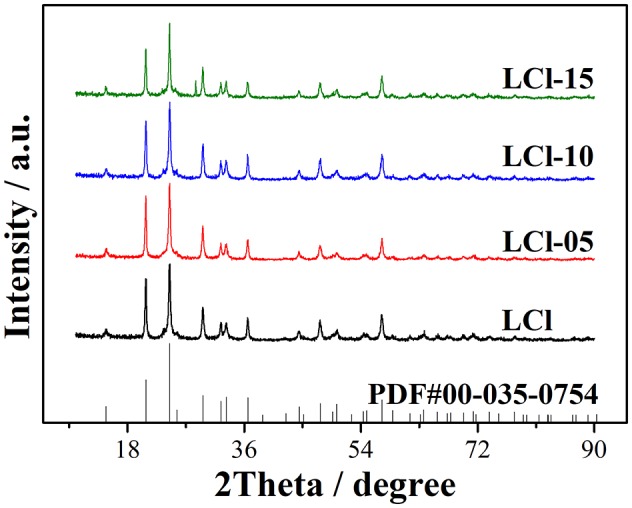
XRD patterns of NaTi2(PO4)3−xCl3x/C (x = 0.0, 0.05, 0.10, and 0.15) composites.